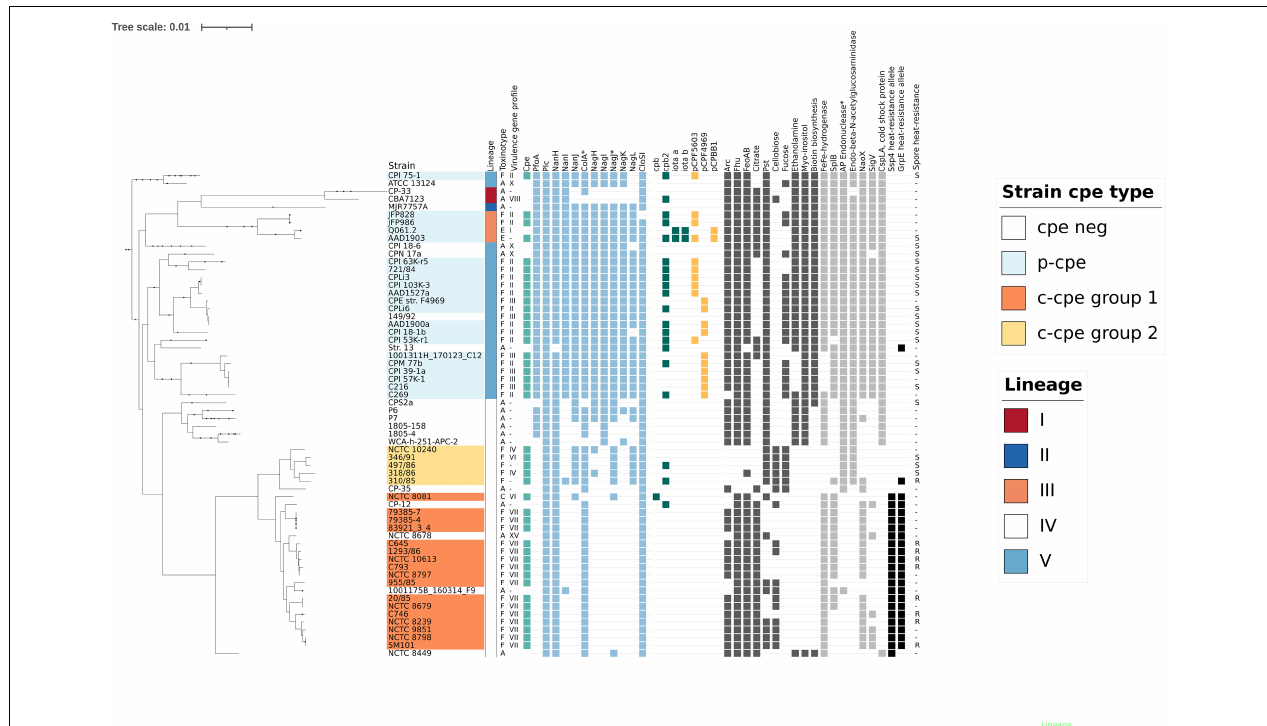
FIGURE 3 | Lineages (I–V) (Feng et al., 2020), toxinotype (A–F) (Rood et al., 2018), virulence gene profile (I–XV) (Abdelrahim et al., 2019), together with selected genetic features (cpe, chromosomal, and plasmid-mediated virulence genes, toxin plasmids, operons, and genes differing between c-cpe strains) are visualized here to demonstrate the results of comparative genome analysis. The maximum-likelihood phylogenetic tree is based on the core genome of 290 strains, and sequenced 30 Clostridium perfringens genomes are shown together with representatives from each lineage. Squares signify the presence of operons or genes in each strain. The spore heat-resistance phenotype based on our results is indicated: “R” signifies heat-resistant phenotype (D 89 ◦ C over 100 min), “S” heat-sensitive phenotype (D 89 ◦ C 10 min or less), and “-“ that spore heat-resistance phenotype for the strain is unknown. Arc = arginine deiminase pathway, Fhu = ferrichrome uptake system, FeoAB = iron uptake system, Citrate = citrate metabolism, Pst = phosphate ABC-transporter, Cellobiose = cellobiose metabolism operon, Fucose = Fucose metabolism operon, Ethanolamine = ethanolamine utilization operon, Myo-inositol = myo-inositol utilization operon, Biotin biosynthesis. Genes (light gray): SplB – spore photoproduct lyase, NaoX – CoA-disulfide reductase, SigV – sigma V. Alleles and SNPs (black): Ssp4 heat resistance allele = gene allele with Asp at residue 36 and Asn at residue 72 (J. Li and McClane, 2008), GrpE allele (CPF_0240) putatively associated with spore heat resistance (CPF_0240) with hydrophobic valine (V) at residue 37. Plasmid-mediated toxin genes netB , etx , tpeL , or lam were not present in any genomes presented here and have been omitted from this figure. * = Some genomes carried divergent ortholog, gene considered